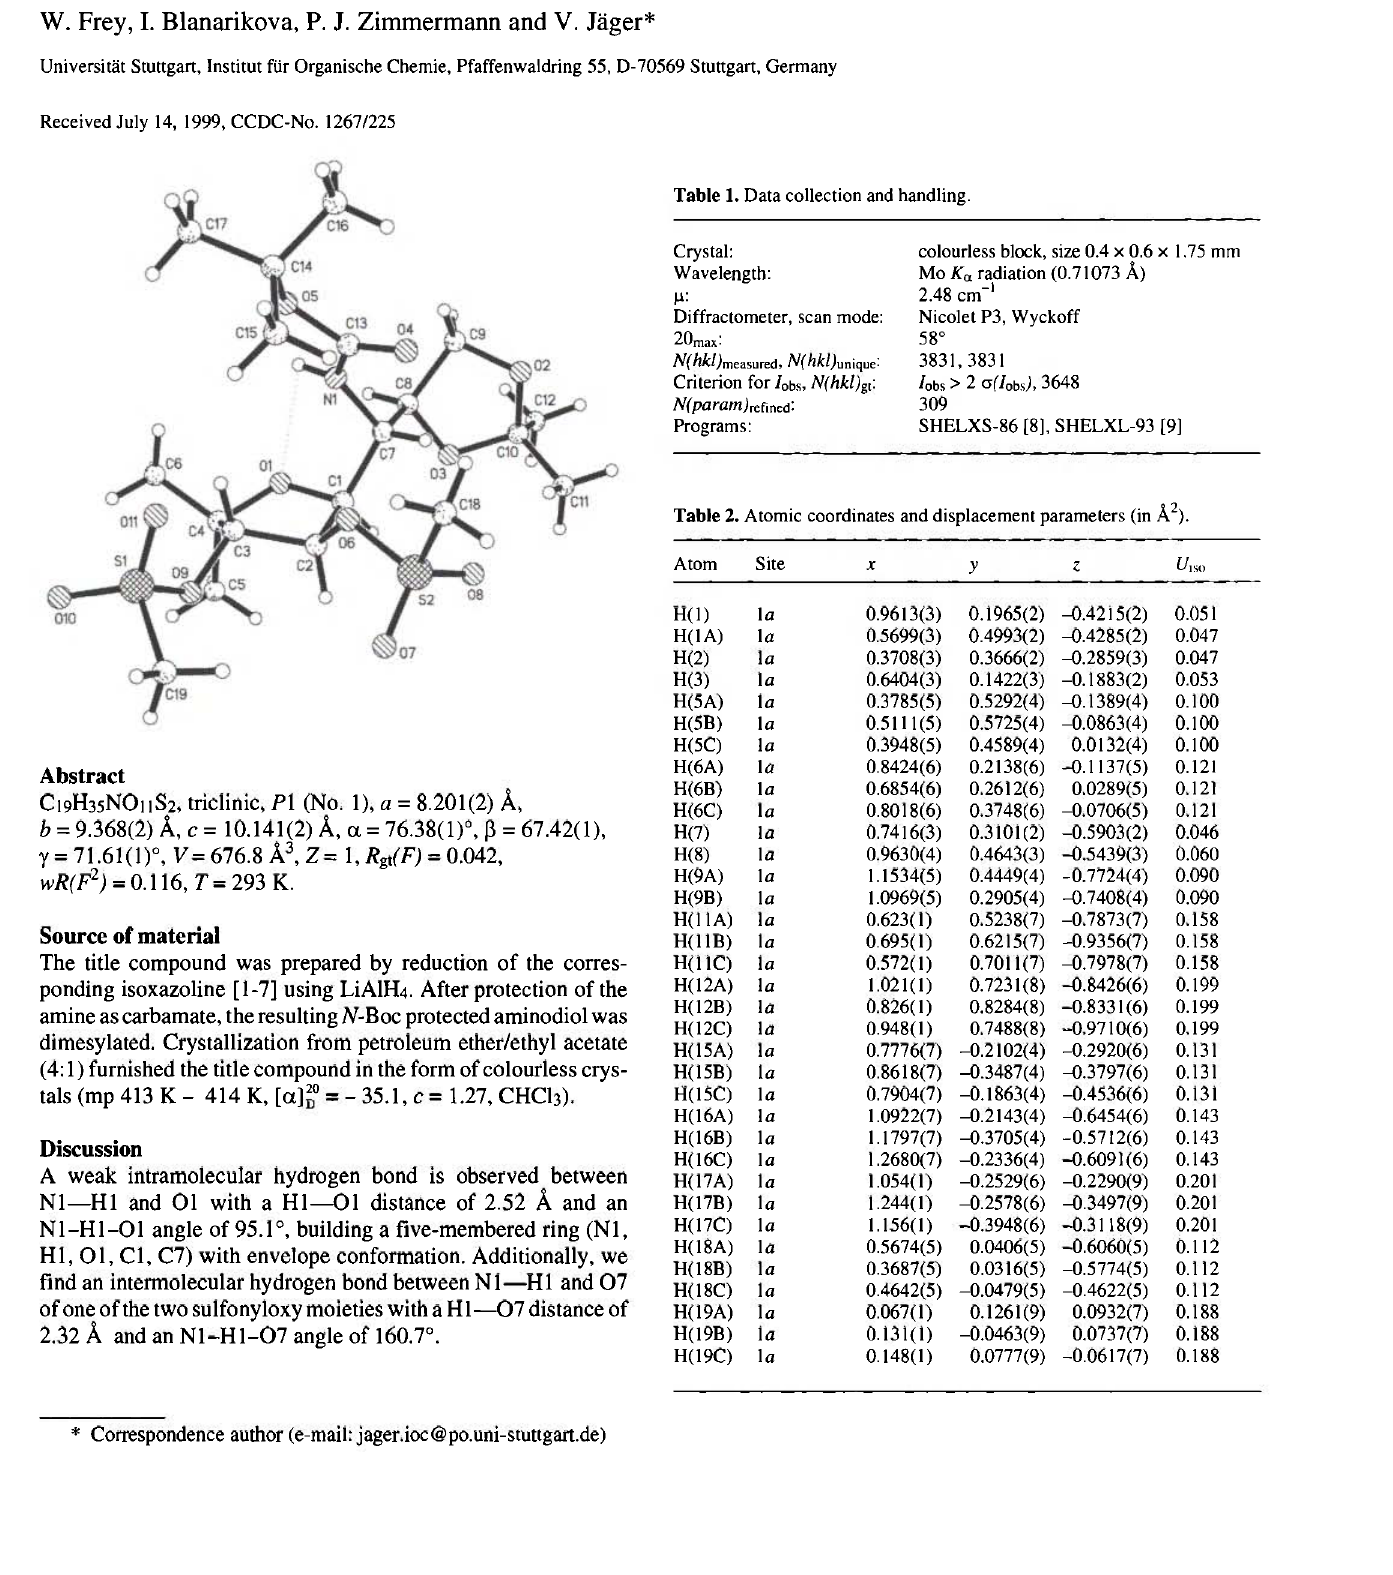
Table 2. Atomic coordinates and displacement parameters (in Ä 2